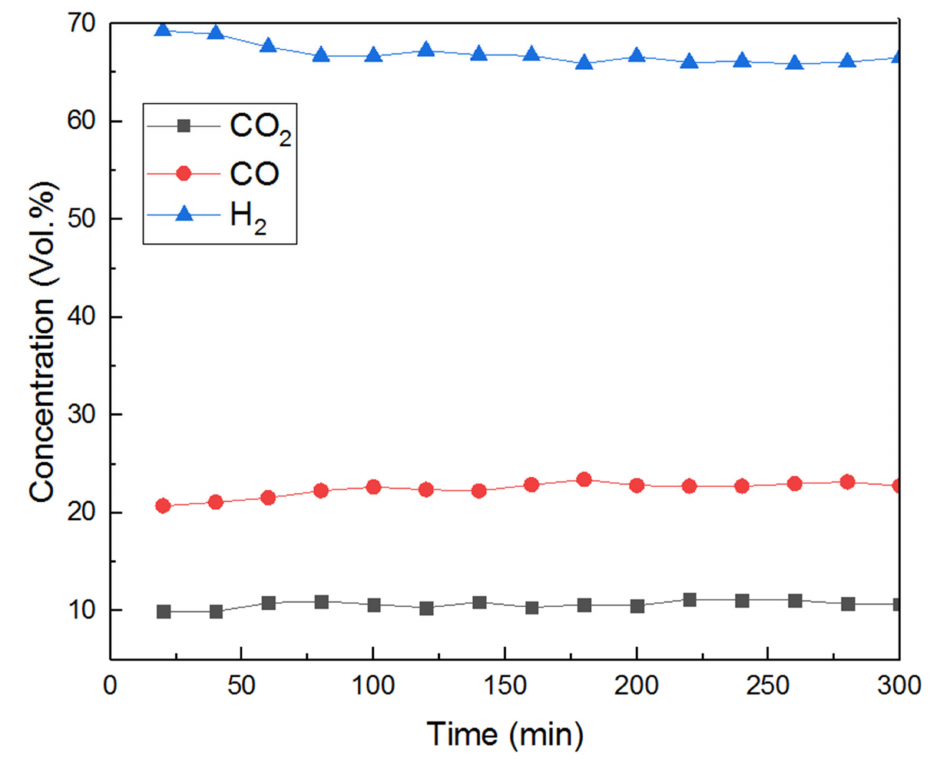
Figure 4. Gas product concentration at 800 ◦ C, S / C:3, GHSV:61,200 h − 1 in a 5-h